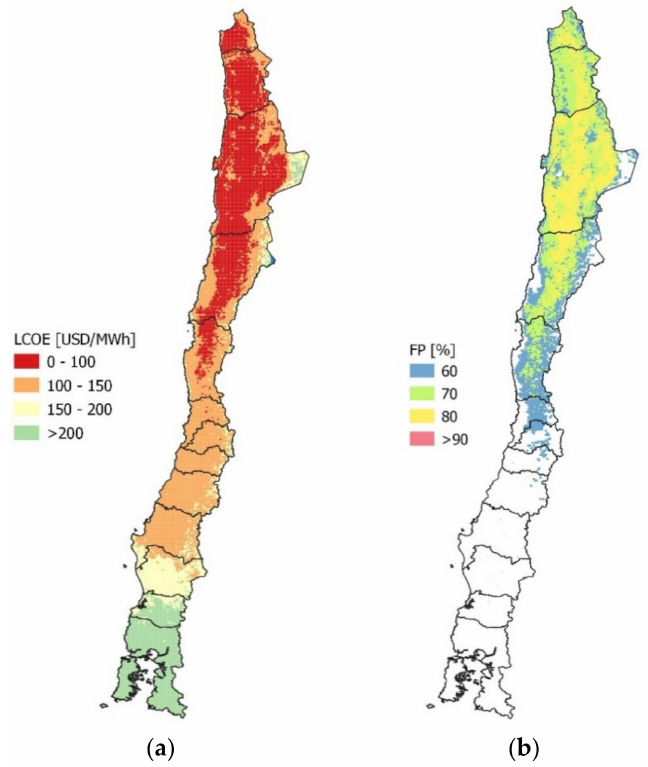
Figure 6. Maps of the ( a ) LCOE in ranges 0–100, 100–150, 150–200 and > 200 USD / MWh. ( b ) Capacity factor (FP) over